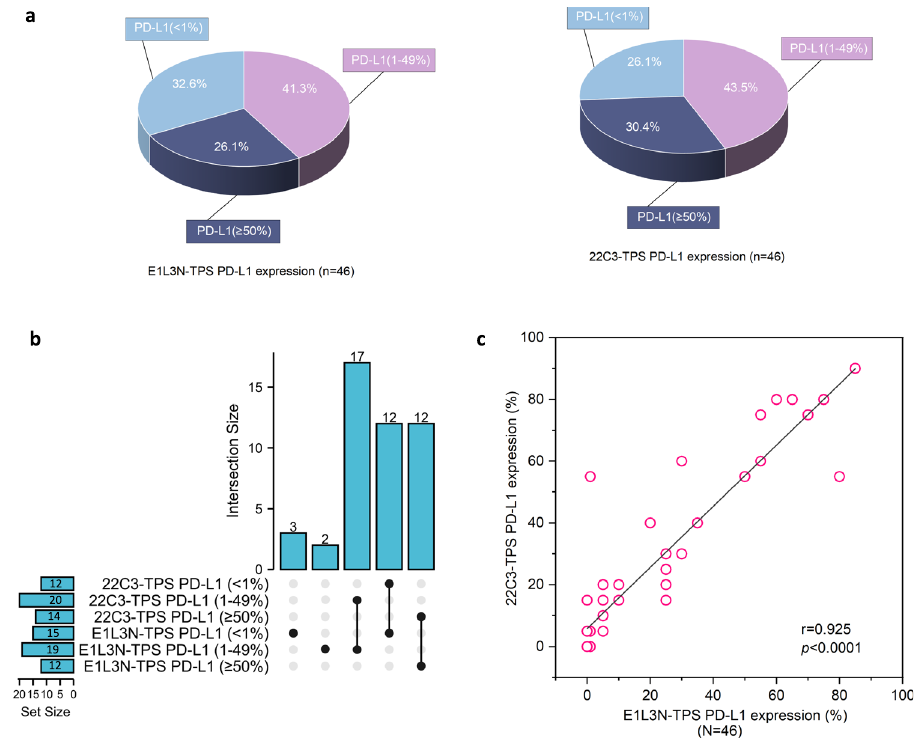
Fig. 3 PD-L1 tumor proportion scores (TPS) were concordant between E1L3N and 22C3. a Pie chart showing the distribution of the cohort strati fi ed according to PD-L1 TPS for E1L3N (left) and 22C3 (right). b UpSet plot illustrating the intersection/concordance between 22C3 and E1L3N TPS subgroups. The height of the columns corresponds to the numbers labeled on top of each column, which indicates the number of intersected data. The dots below the columns indicate the subgroup to which the data belongs to. The connected dots below the columns indicate the number of patients having concordant PD-L1 TPS categorized as <1% ( n = 12), 1 – 49% ( n = 11), and ≥ 50% ( n = 7). The bar plot on the left side illustrates the sample size per subgroup. c Correlation plot showing the positive correlation between PD-L1 TPS scores for E1L3N assay ( x -axis) and 22C3 assay ( y -axis). The correlation between 22C3 TPS and E1L3N TPS was computed using Pearson Correlation Coef fi cient ( R 2 ). Abbreviations: TPS tumor proportion